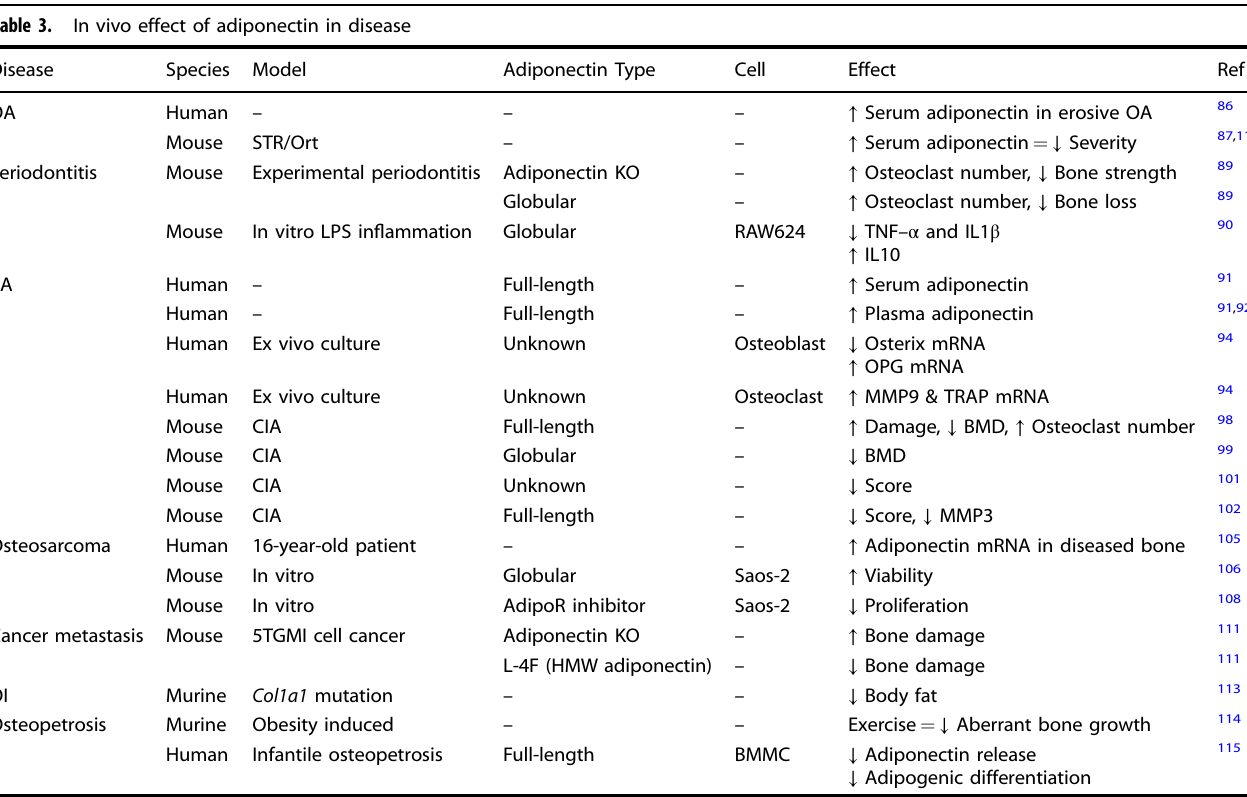
Table 3. In vivo effect of adiponectin in disease Disease